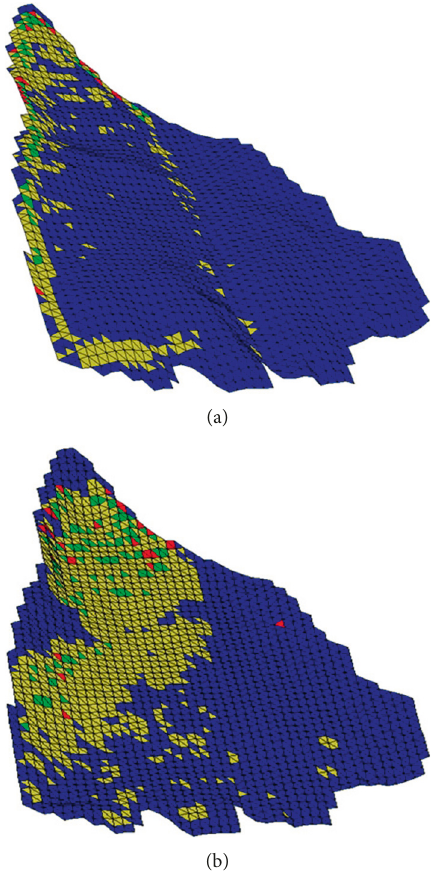
Figure 17: The plastic zones of the landslide deposit (a) and the slip zone (b) in natural condition.